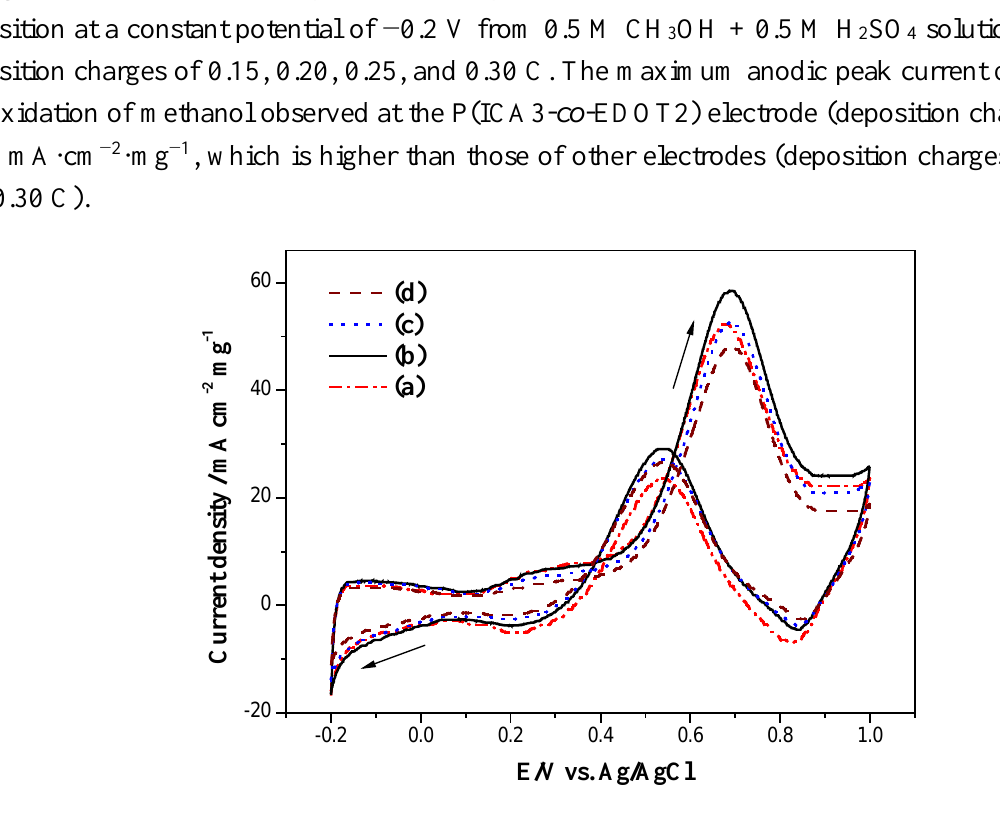
Figure 7. Cyclic voltammograms of P(ICA3- co -EDOT2) with various Pt deposition charges of ( a ) 0.15; ( b ) 0.20; ( c ) 0.25; and ( d ) 0.30 C in 0.5 M CH 3 OH + 0.5 M H 2 SO 4 solution, scan rate = 50 mV·s −1